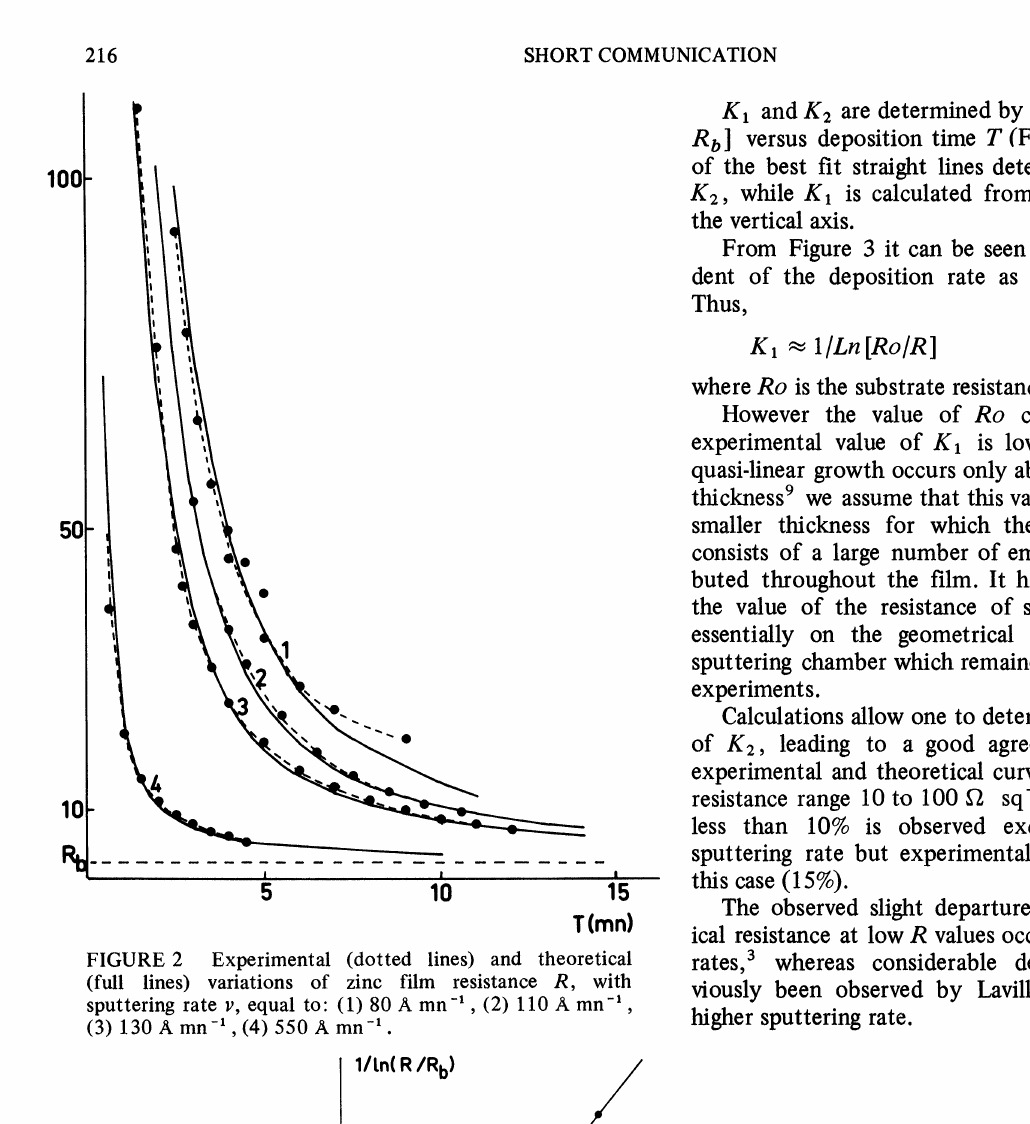
, equal to () 80 A mn